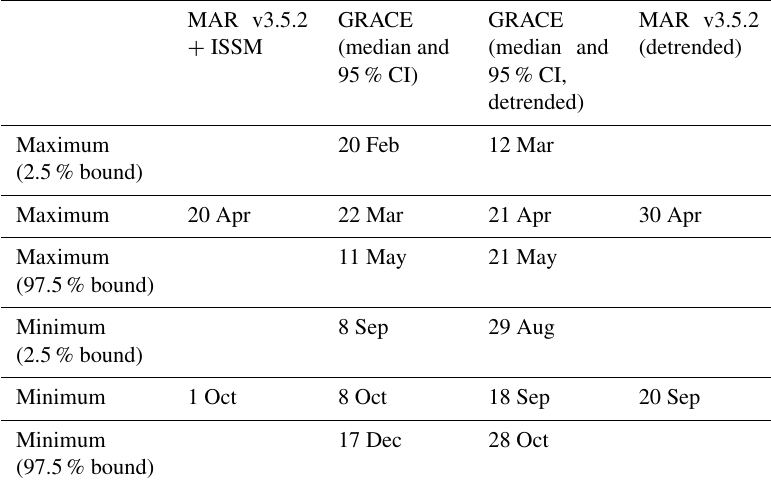
Table 2. Same as Table 1, but for GRACE-LM and MAR v3.5.2 + ISSM (with Gaussian spatial and temporal filtering), for the period January 2003–December 2012.